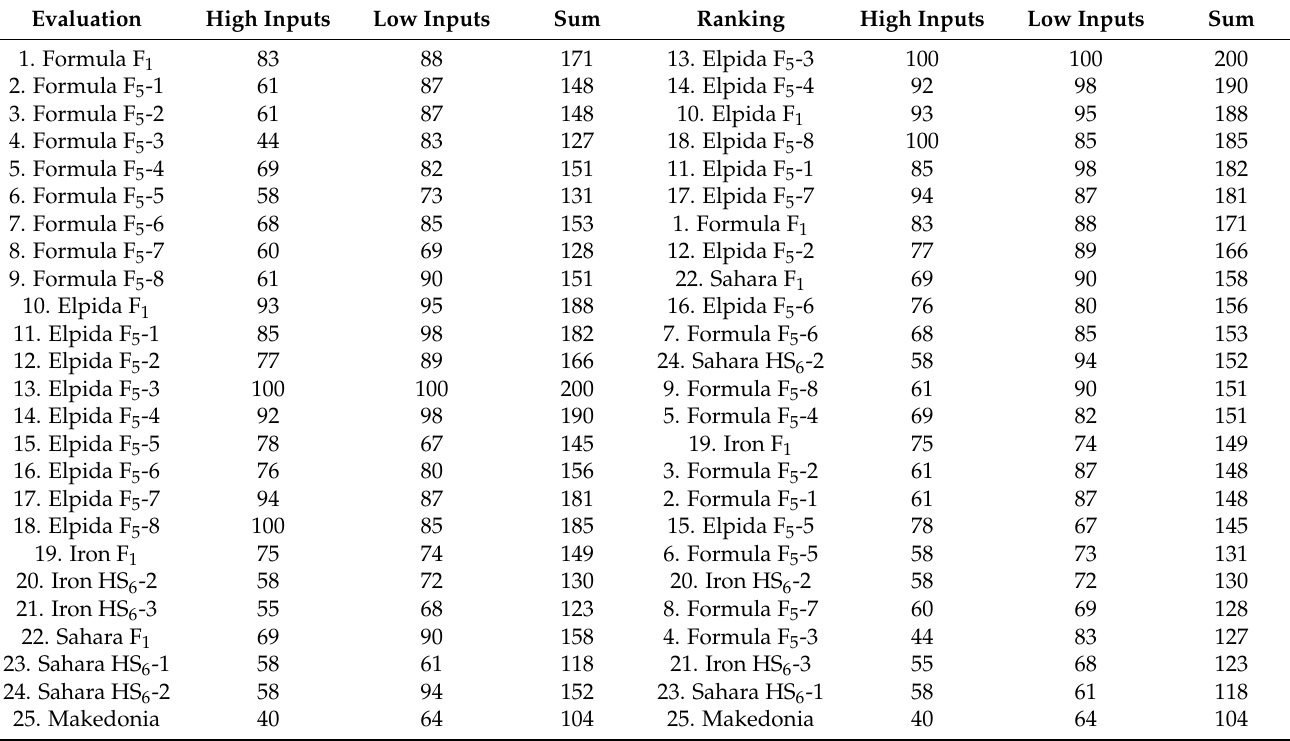
Table 6. Relative total yield (% of the best entry) of the hybrids and inbred lines derived from them in two (high- and low-input) farming